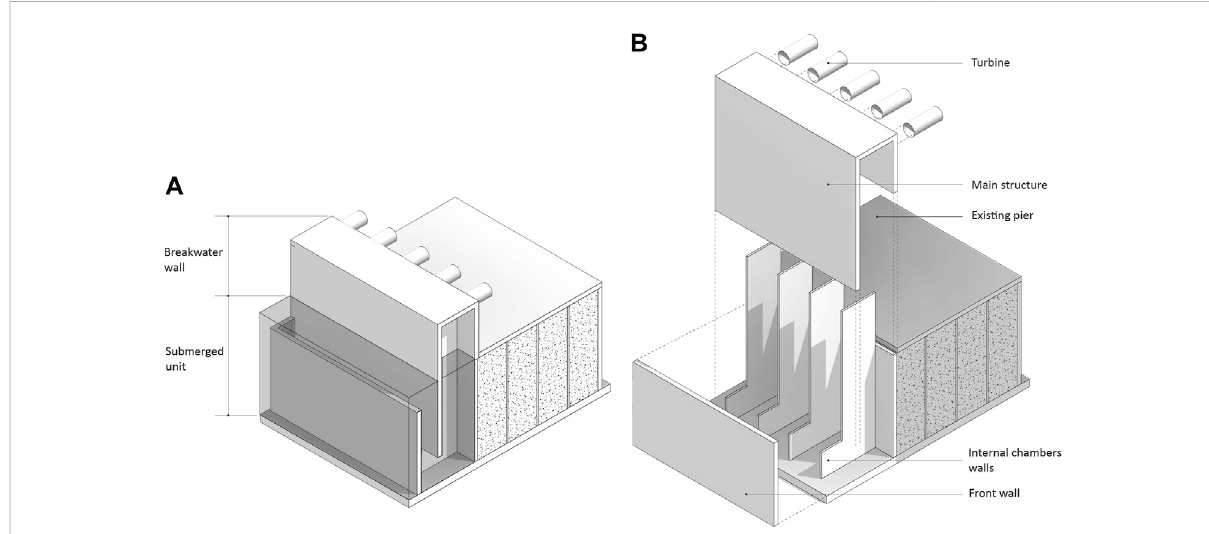
FIGURE 1 The onshore OWC 3D model (A) and its main construction elements (B) . Legend and values: breakwater wall height = 6 m; submerged unit height = 10